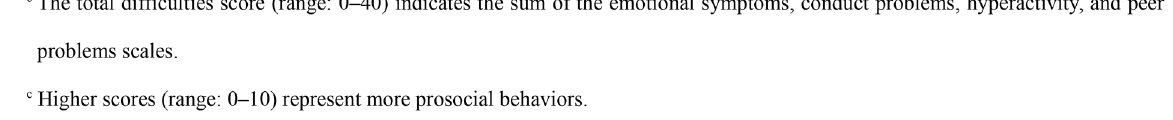
Figure 2. Comparison of SDQ score due to differences in pre-and during COVID-19